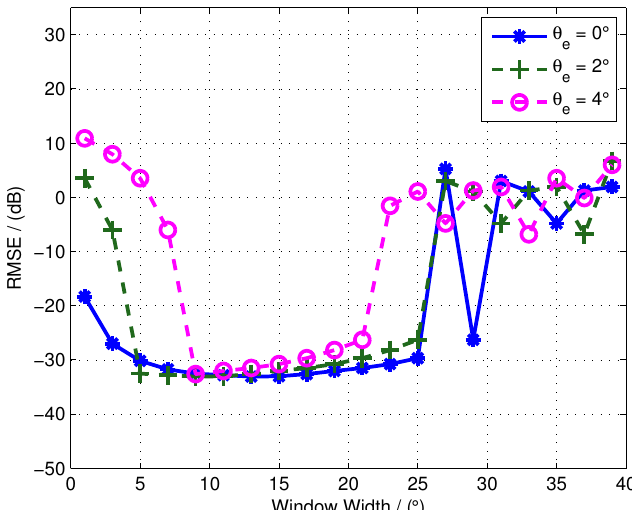
Figure 7. DOA estimation accuracy results obtained by the SSC-MVDR algorithm when the width of the direction interval varies between 1 and 40 degrees, and the deviation of the center of the direction interval from the true DOA is equal to 0, 2, and 4 degrees,